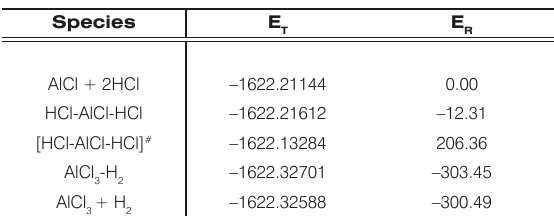
Table 2. CCSD(T)/6-311G(d,p)//B3LYP/6-311G(d,p) + ZPE Total Energies E (a.u.) and relative energies ER (kJ mol -1 ) for T the reaction AlBr + HBr (reaction channel (2)).